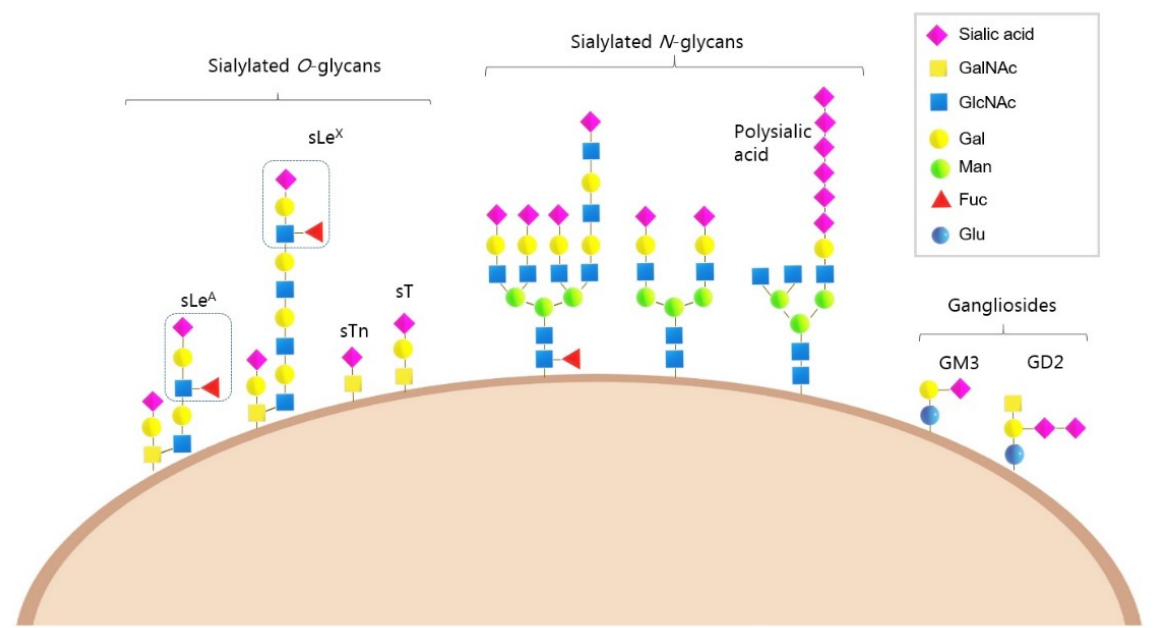
Figure 1. Hypersialylation is a common feature of cancer cells. Tumour cells have increased levels of sialylated glycans on their cell surface, which include sialyl Lewis A (SLe A ), sialyl-Lewis X (SLe X ), sialyl-Tn (sTn), Sialyl-T (sT), polysialic acid (polySia), GM3 and GD2 antigens. Table 1. Summary of sialylation changes in cancer.